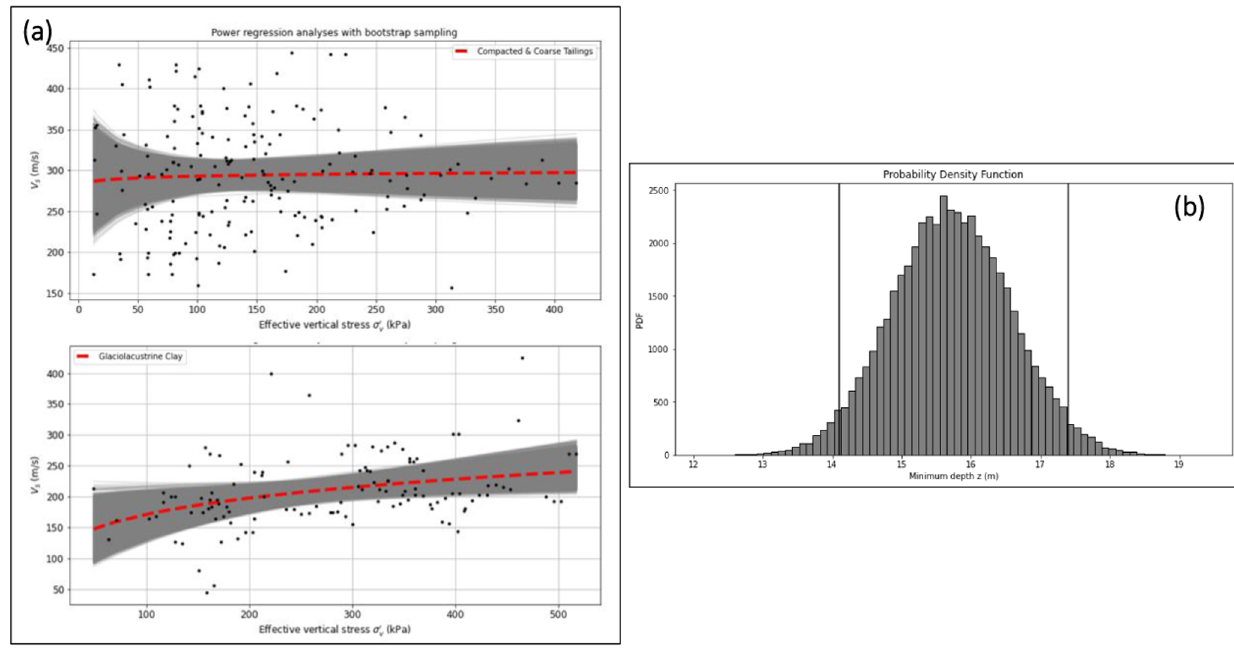
Fig. 5 Power-law regression analyses on other stratigraphic units and probability density function of the minimum depth. a Estimation of site speci fi c α and β from power-law regression using V s estimates from sCPT surveys and effective vertical stress for compacted and coarse tailings (upper plot) and glaciolacustrine clay (lower plot) materials. Bootstrap analyses, shown in shaded gray, were used to obtain 95% con fi dence intervals of the α and β parameters. b Probability density functions of the optimal depth z to minimize L1 mis fi t between dv/v estimates with dV s /dV s . Results obtained